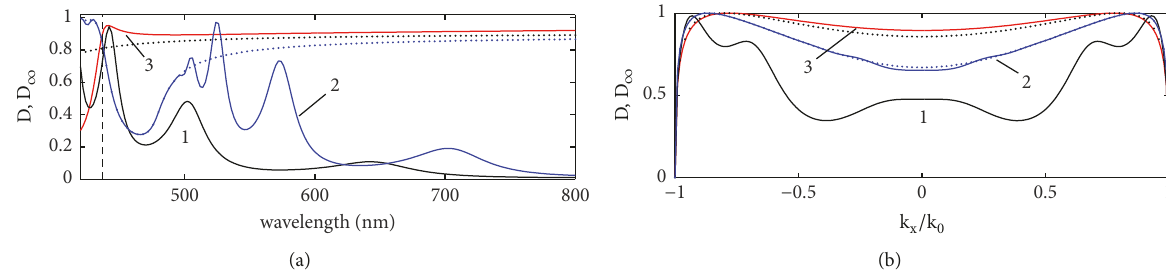
Figure 6: (Color online) the absorption coefficient 𝐷 of the nonuniform metamaterial film (curve 3) compared with MM layer with the fixed optical axis orientation (curves 1 and 2 correspond to 𝜙 = 0 and 𝜙 = 0.1𝜋 ): (a) as a function of the wavelength (at normal incidence) and (b) as a function of the tangential wavevector component of the incident light ( 𝜆 = 500 nm); the thickness of the film is 𝐿 𝑦 = 200 nm. Dotted lines show the absorption coefficient 𝐷 ∞ of the metamaterial half-space 𝜙 = 0 and 𝜙 = 0.1𝜋 .